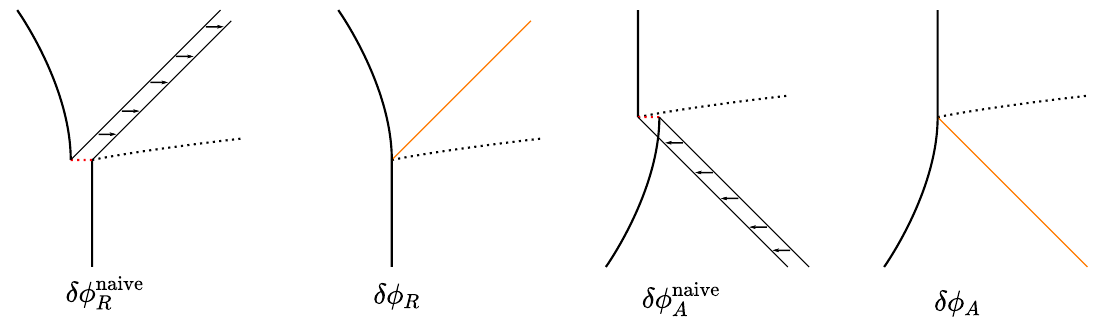
Figure 6 . Boundary jumping in the naive retarded and advanced solutions for the action deformed by ψ . The geodesic y µ ( s ) is shown as a dotted black line. In the naive retarded solution shown s,η t − η here the boundary jumps outwards to the future, so we need to act with a diffeomorphism to move it back. Similarly in the naive advanced solution the boundary jumps inward to the past, so we need to act with a diffeomorphism to move it back. If the matter fields are nonzero in the vicinity of the boundary, then we need to also modify them on the red dashed line in such a way that in the retarded/advanced solution they continue to obey the boundary conditions in the future/past. The diffeomorphism has no physical effect in the interior of the spacetime, but the matter modification can lead to shockwaves shown in orange in the retarded/advanced solutions δφ / δφ R A